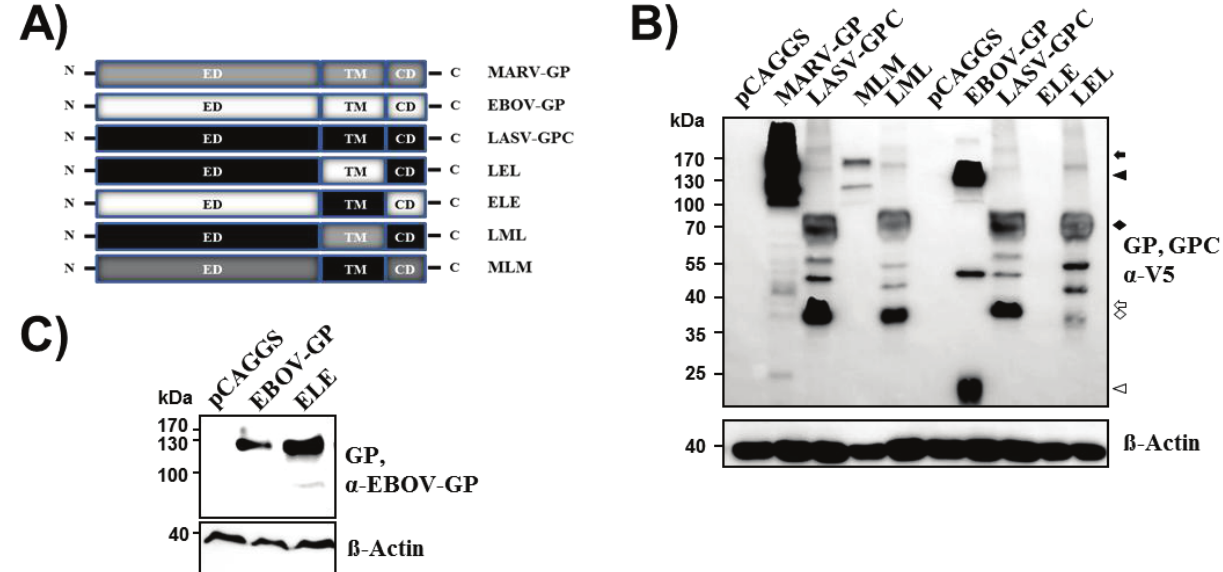
Figure 3. The exchange of the transmembrane domains between filoviral and Lassa virus glycoprotein is compatible with robust expression. ( A ) Schematic overview of the chimeric glycoproteins analyzed. ( B ) Expression of V5-tagged glycoprotein chimeras was tested as described for Figure 1A. Expression of β -actin in cell lysates was determined as loading control. Bands corresponding to glycoprotein precursors and their mature, transmembrane units are marked as described for Figure 1A. ( C ) Expression of EBOV-GP wt and mutant ELE in the cell lysates analyzed in ( B ) was determined employing an antibody raised against EBOV-GP. Signals correspond to the surface unit GP1. Expression of β -actin in cell lysates was determined as loading control. The results were confirmed in at least two separate